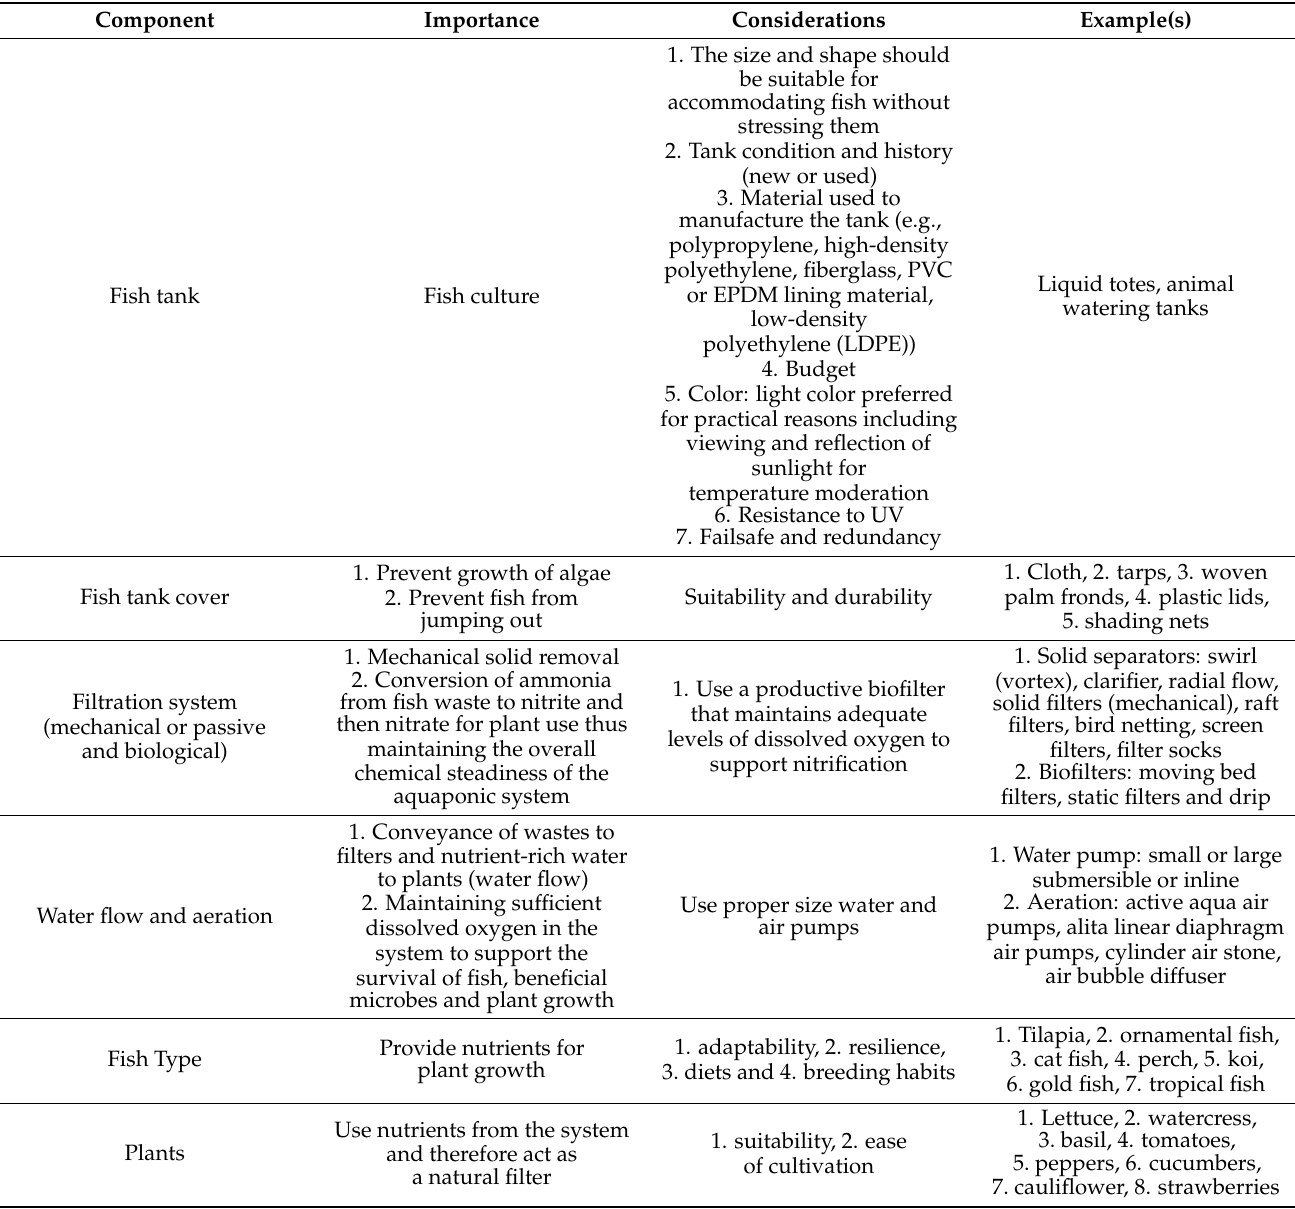
Table 4. Aquaponics system components: relevance, considerations for selection and